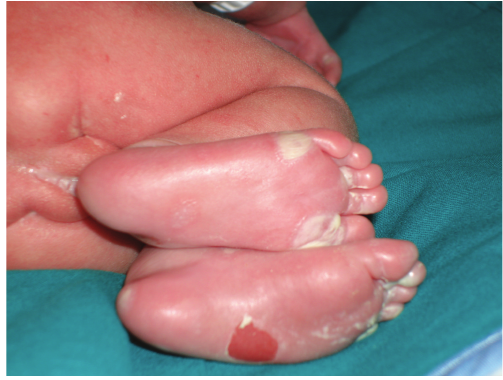
Figure 1: Typical blistering skin lesions on the soles of feet in the case described.